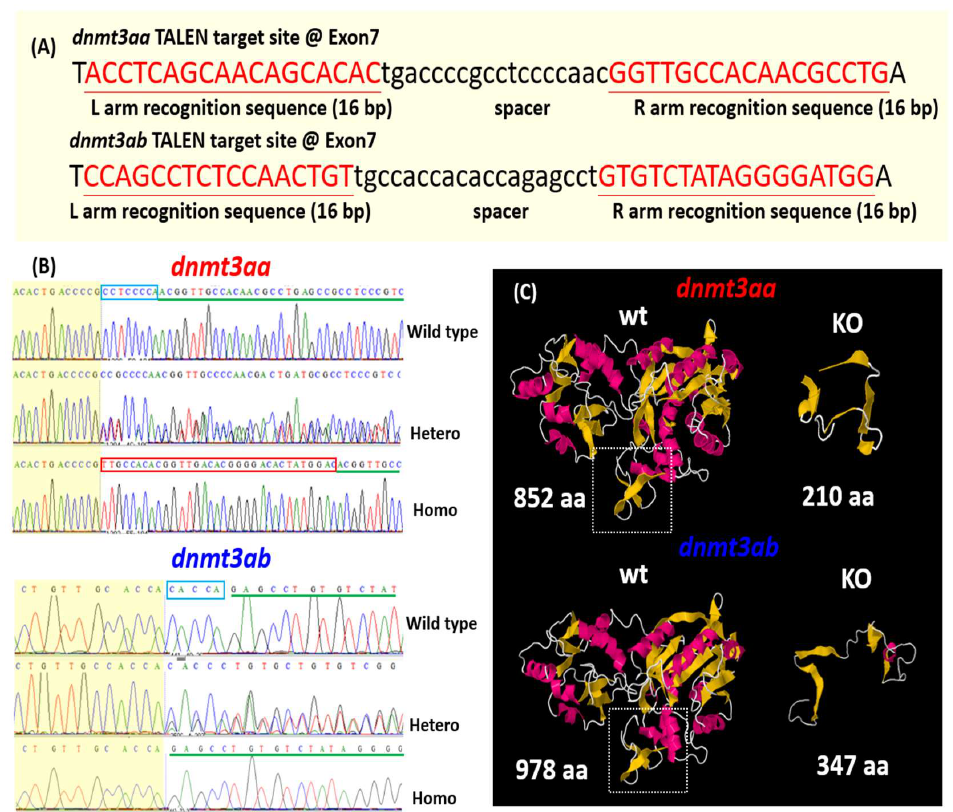
Figure 1. Generation of dnmt3aa and dnmt3ab gene knockout (KO) zebrafish by using TALEN (transcription activator-like effector nuclease) genome-editing tool. ( A ) The location of TALEN right arm, spacer, and left arm on targeting zebrafish dnmt3aa and dnmt3ab genes are showed. ( B ) The Sanger sequencing dendrogram showed the sequence of wildtype, heterozygotes, and homozygotes of dnmt3aa (upper panel) and dnmt3ab (lower panel) mutants. ( C ) Three-dimension model predictions on the structure of wild type and Dnmt3aa and Dnmt3ab mutated proteins.